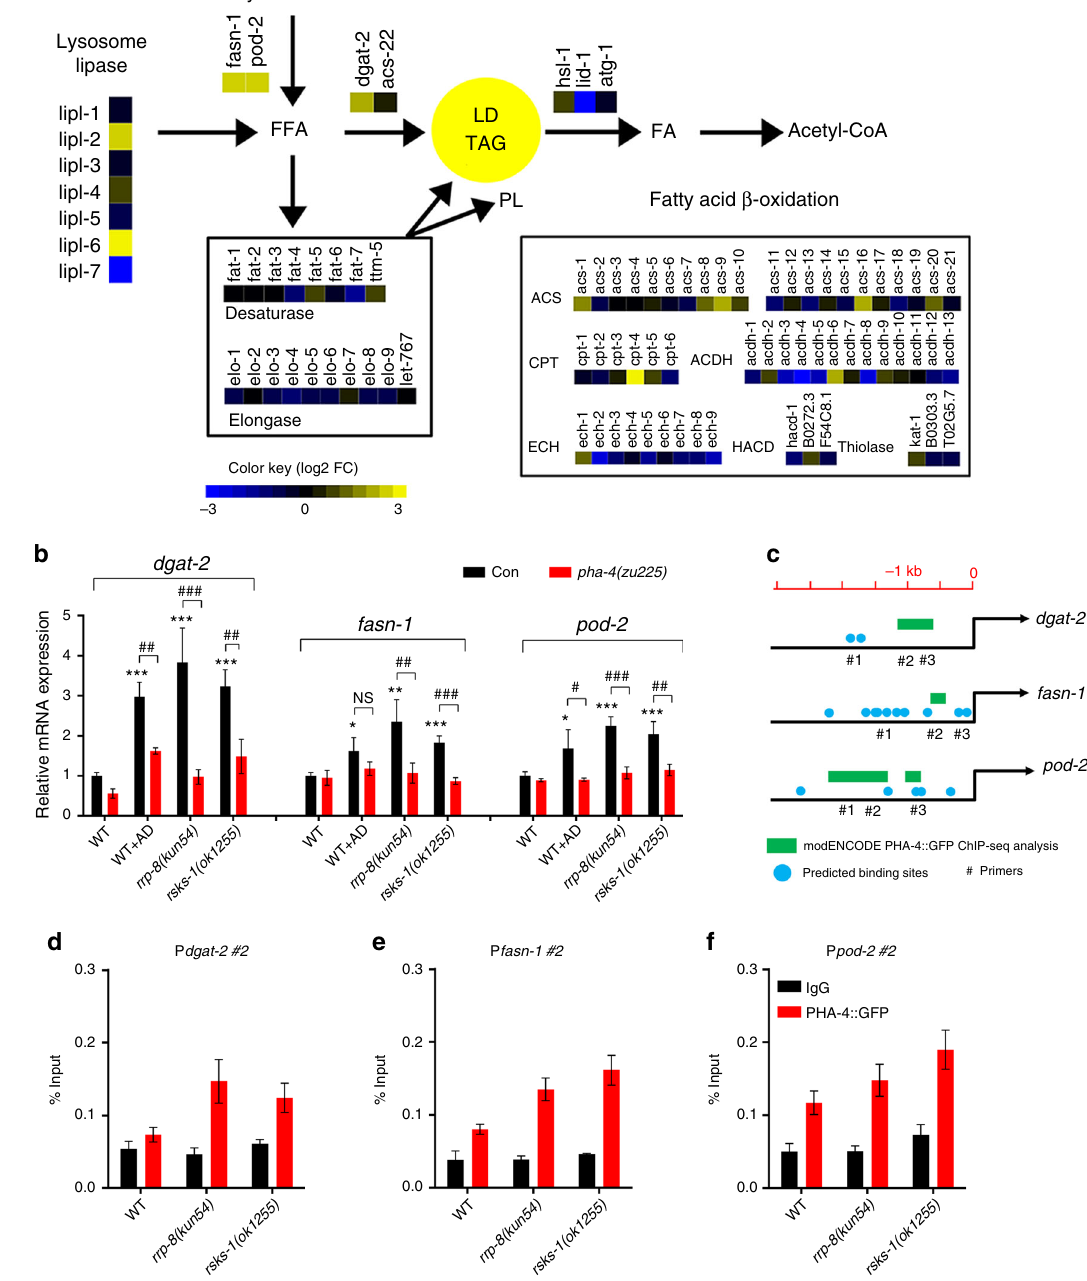
Fig. 6 Nucleolar stress enhances PHA-4 binding and transactivates the expression of lipogenic genes. a Transcriptional expression of lipid metabolic genes using transcriptome pro fi le analysis between WT and rrp-8 ( kun54 ) mutant worms. Abbreviations: ACDH, acyl-CoA dehydrogenase; ACS, acyl-CoA synthetase; CPT, carnitine palmitoyltransferase; ECH, enoyl-CoA hydratase; FA, fatty acids; HACD, hydroxyacyl-CoA dehydrogenase; PL, phospholipid; TAG, triacylglycerol. b Relative mRNA expression of dgat-2 , fasn-1 , and pod-2 in different worm strains or treatments. Data are presented as the means± SD of four biological repeats. Signi fi cant difference between WT and a speci fi c worm strain, ANOVA, *** P < 0.001, ** P < 0.01, * P < 0.05. Signi fi cant difference between a speci fi c worm strain with and without the pha-4 ( zu225 ) background, Student ’ s t -test, ### P < 0.001, ## P < 0.01, # P < 0.05. NS, no signi fi cant difference. c Potential PHA-4-binding sites in the promoter region of the lipogenic genes fasn-1 , pod-2 , and dgat-2 . The green rectangles were reported in the modENCODE GFP ChIP-seq analysis and the blue dots were predicted based on the characterized PHA-4-binding elements. #1, #2, and #3 represent different primer pairs in the promoter region of different genes for ChIP-QPCR detection. d – f ChIP-QPCR analysis of PHA-4 bound to the promoters of the fasn-1 , pod-2 , and dgat-2 genes. d P dgat-2 #2, e P fasn-1 #2 and f P pod-2 #2 indicate the #2 primer pair in the promoter region of respective genes used for ChIP-QPCR analysis. Data are presented as the means ± SD of three biological